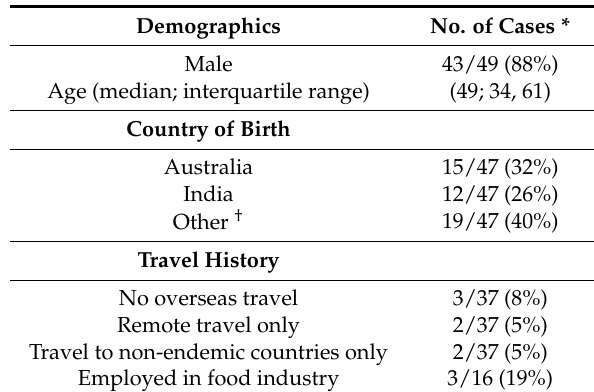
Table 1. Demographic data of patients with invasive amoebiasis at Western Sydney Local Health District between 2005 and 2016.